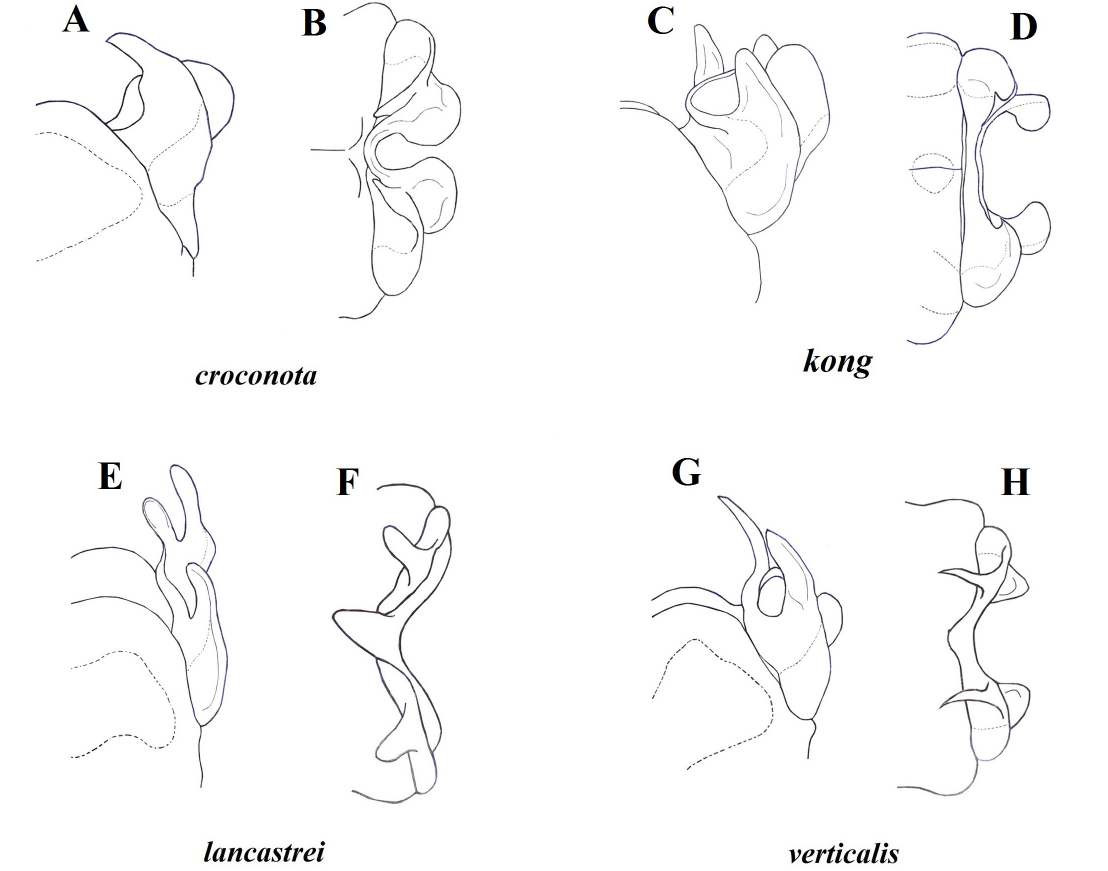
Fig. 13. Posterior pronotal lobe of prothorax of Prodasineura Cowley, 1934 spp., females, lateral and dorsal views. A–B . P. croconota Ris, 1916, ZCDTU 2017060802-ODO. C–D . P. kong sp.